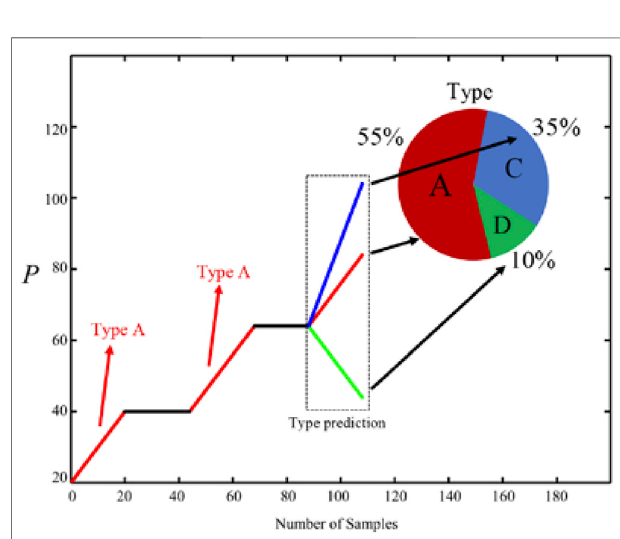
FIGURE 4 | Type prediction of ramping